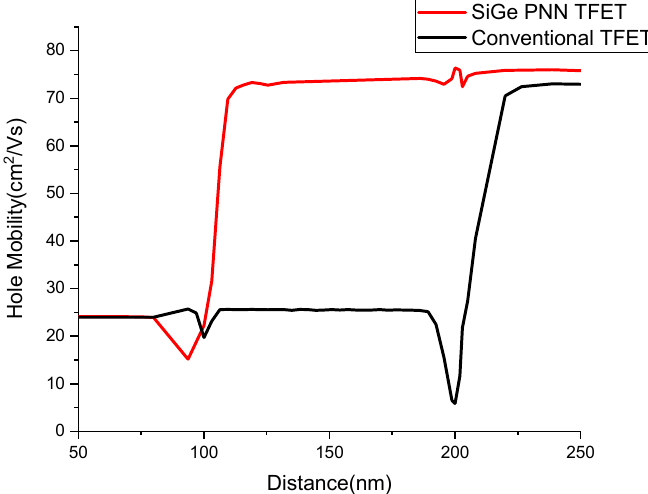
Figure 9. Hole mobilities at a distance of 5 nm below the Si/HfO 2 interface.